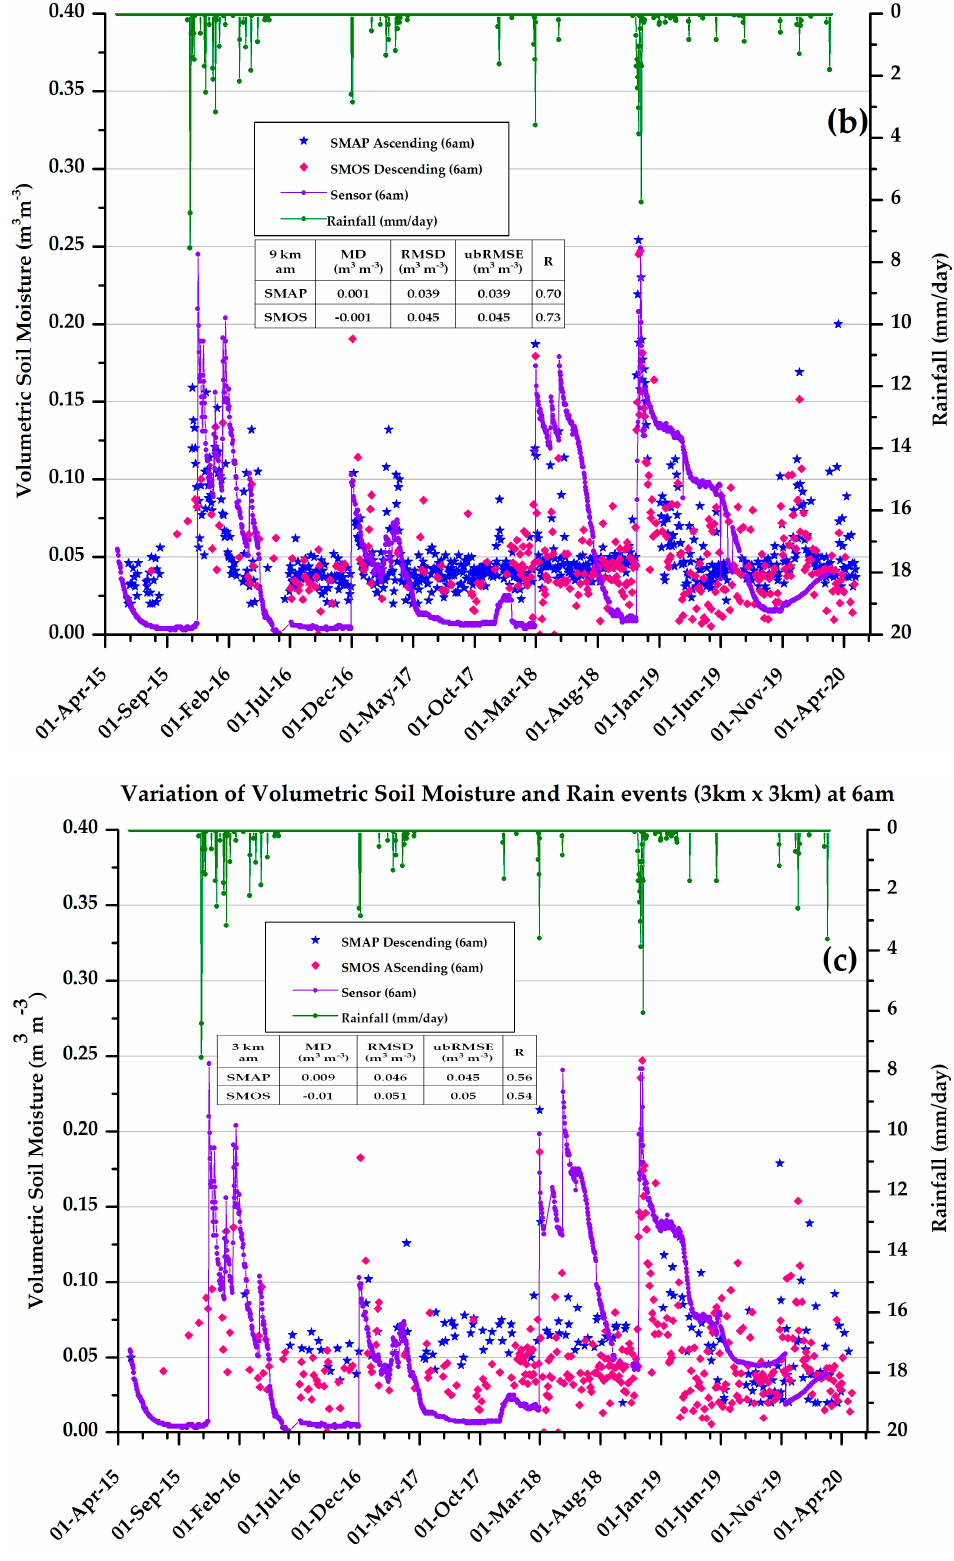
Figure 10. Validation of VSM from SMAP and SMOS 6 am overpass using ground station sensors and rainfall records at ( a ) 36 km, ( b ) 9 km, and ( c ) 3 km.